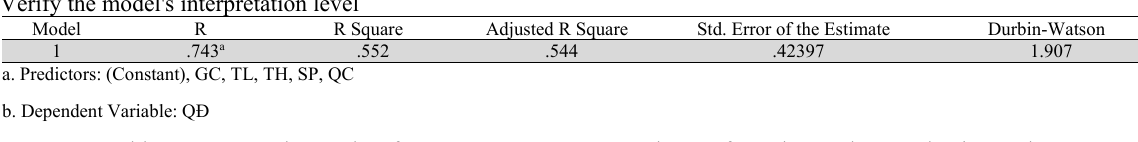
Table 8 Testing partial correlation of regression coefficient (2nd time) Model